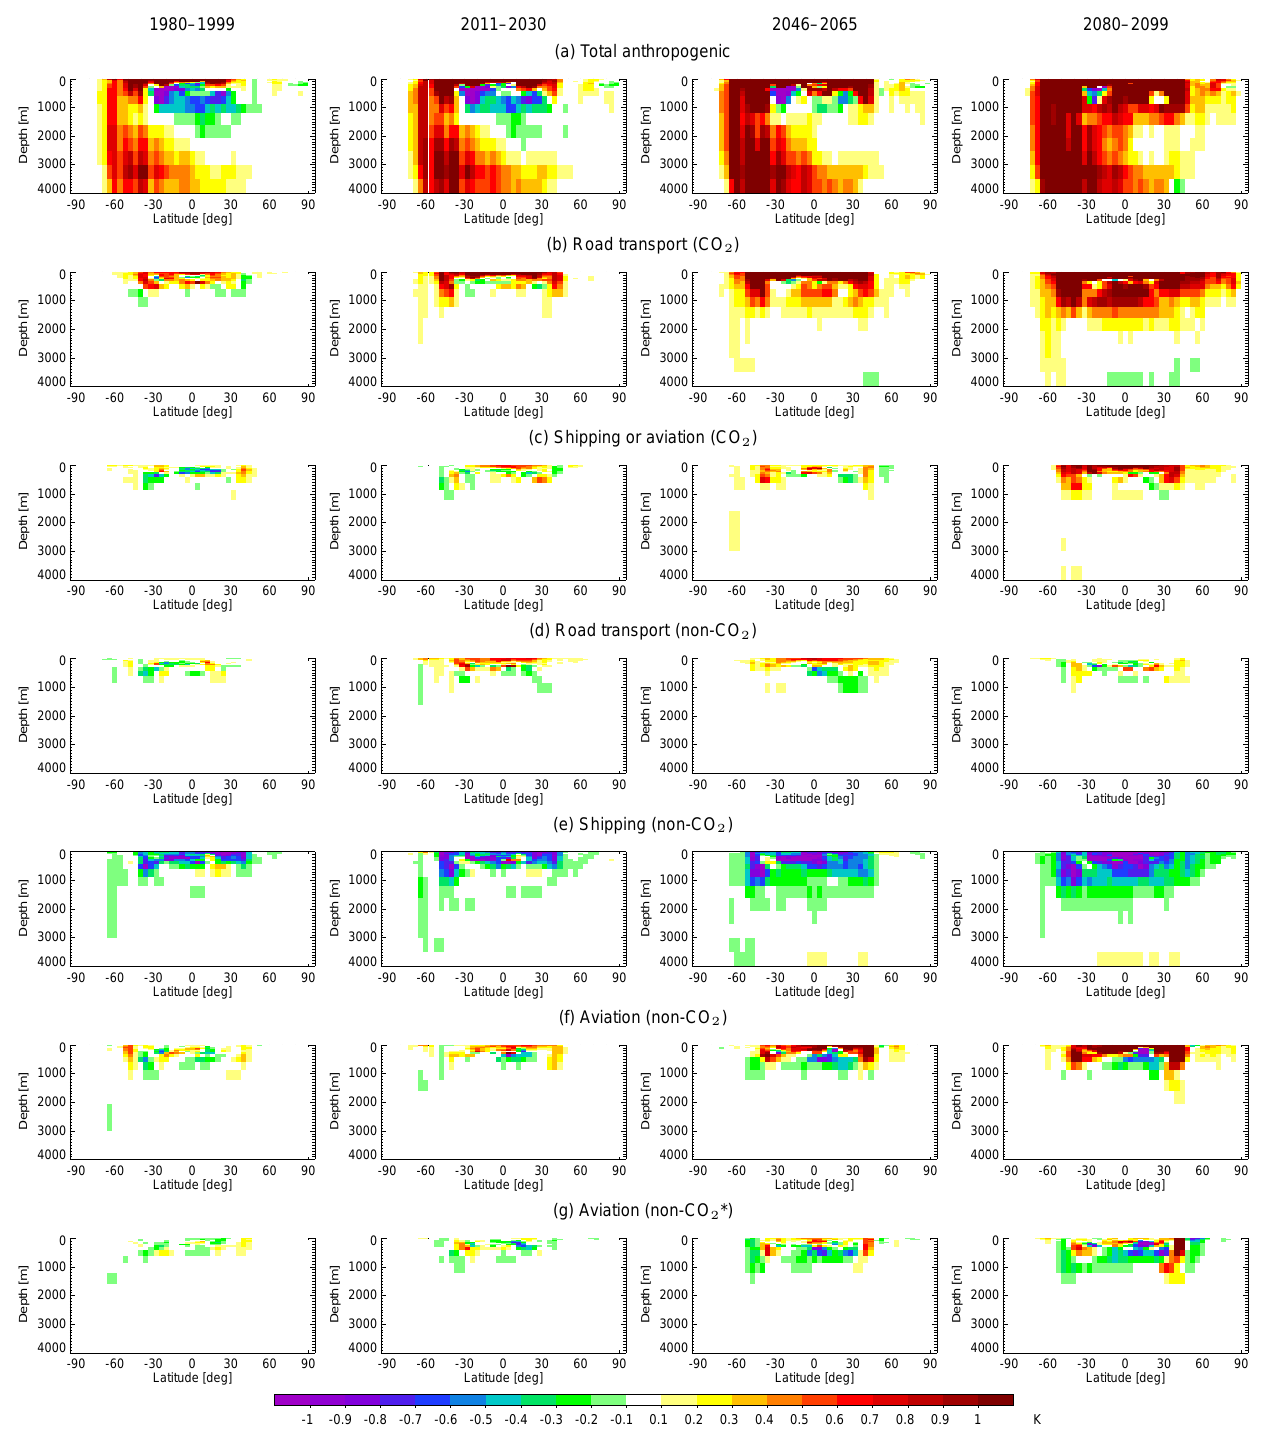
Fig. 18. Zonally averaged annual mean impact on the ocean temperature (in K) for the four different reference periods. The order of the plots is as in Fig. 10.